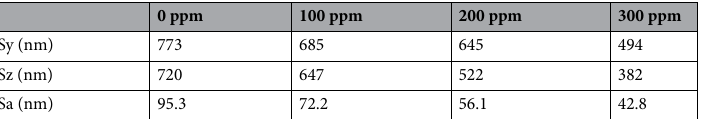
Table 4. Surface roughness parameters from AFM images from MS after 3 h dipping in the acid solution at different GSE concentrations.